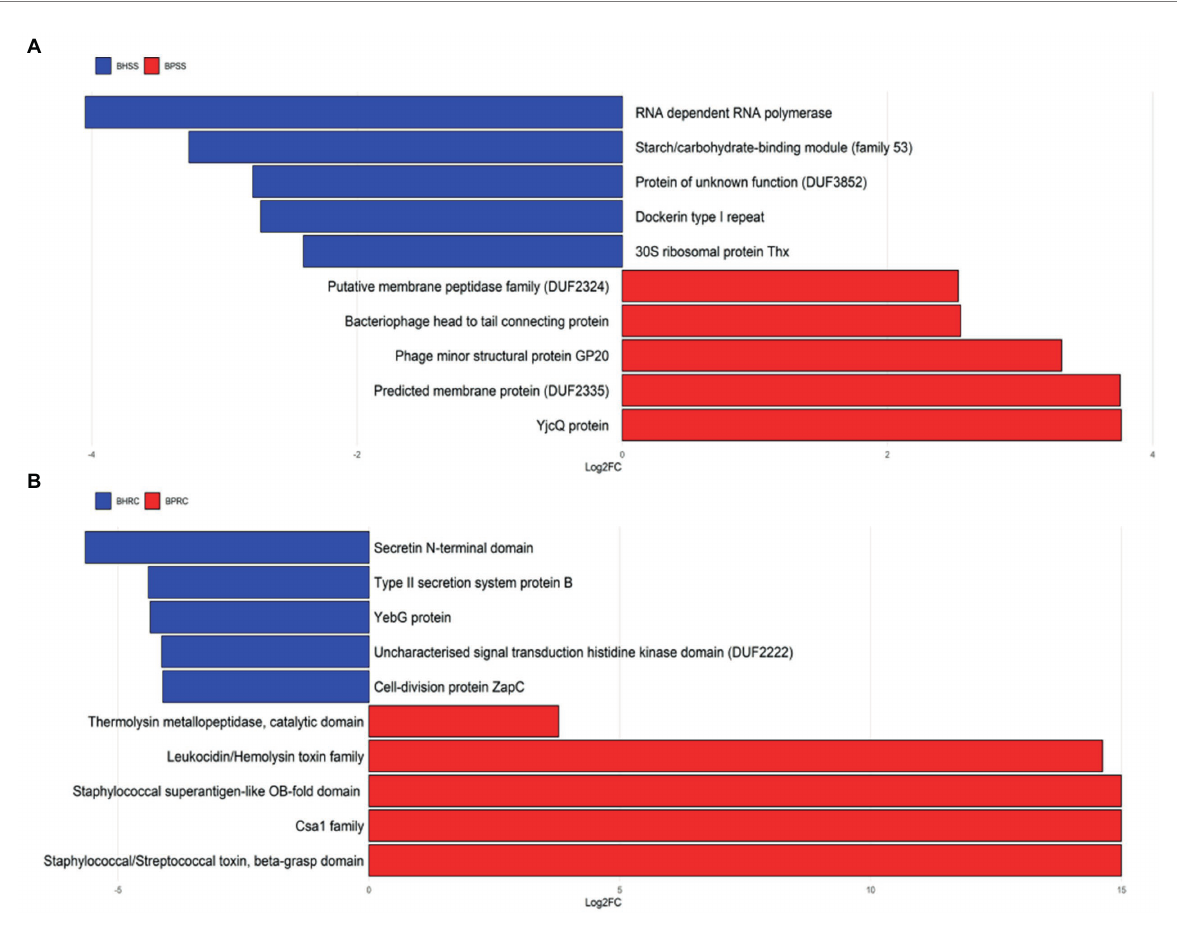
FIGURE 8 Differentially abundant protein families in cattle with periodontitis and healthy controls predicted with PICRUSt2. (A) Dental biofilm of clinically healthy cattle (BHSS) and those with periodontitis (BPSS). (B) Ruminal microbiome of clinically healthy cattle (BHRC) and those with periodontitis